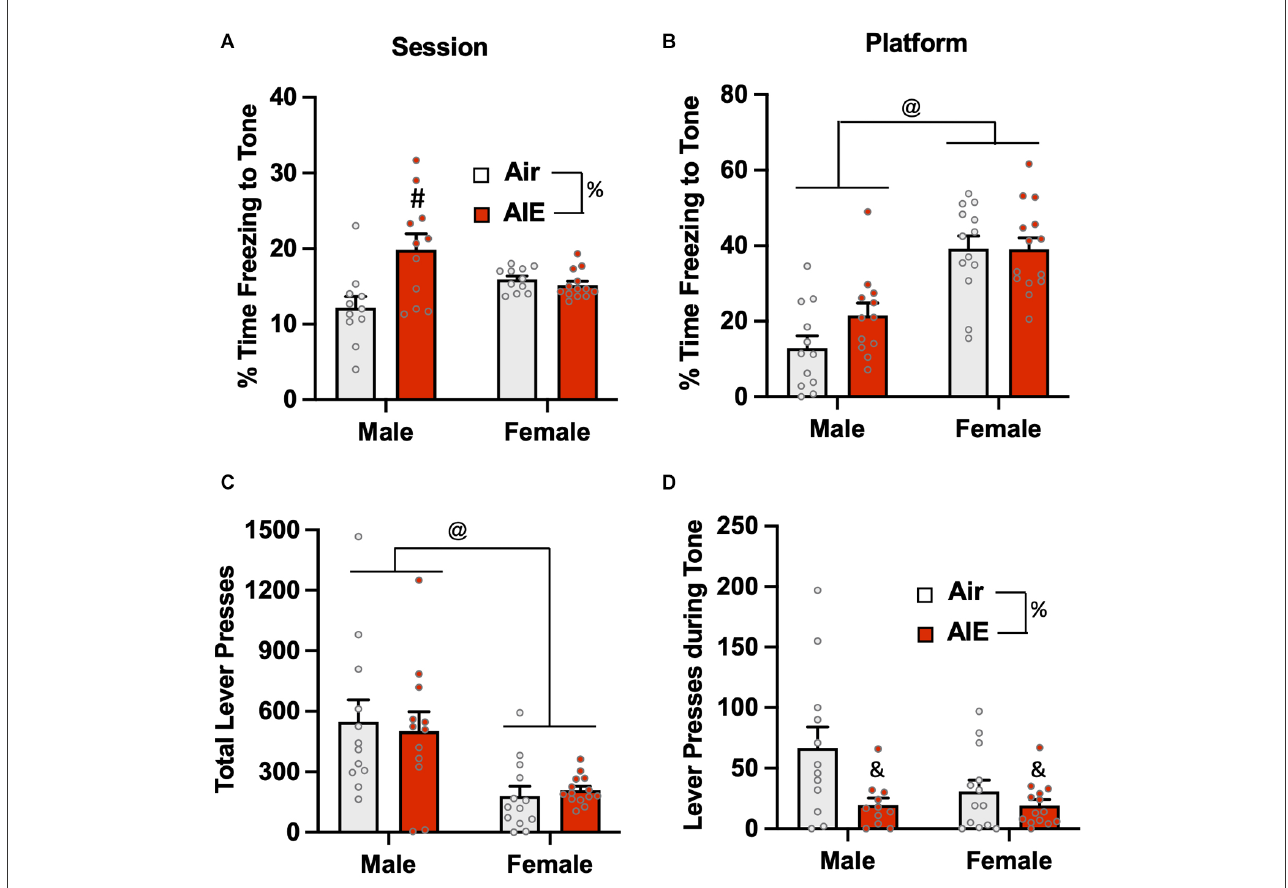
FIGURE7 Freezing behavior and lever pressing on the last day of extinction of the platform-mediated avoidance task. (A) When freezing during tone presentation on the last day of extinction was examined irrespective of platform location, male AIE-exposed rats froze significantly more compared to male Air rats. (B) When analysis of freezing to the tone was restricted to the period when the rats were positioned on the platform, female rats froze significantly more than male rats. During the period, the significant increase in freezing in the male AIE-exposed rats compared to the male Air rats was no longer observed. (C) Examination of total lever responding during the test session revealed lever pressing by female rats was significantly reduced compared to male rats. (D) AIE-exposed male and female rats also exhibited reductions in lever pressing during presentation of the tone. Data represent the means ± sem ( n = 12–13/group). % indicates a significant main effect of AIE, all p values < 0.01. @ indicates a significant difference between male and female rats, p = 0.000; & indicates significant difference of AIE group compared the their respective Air group, all p values < 0.05; # indicates significant difference between mail Air and AIE rats, p =